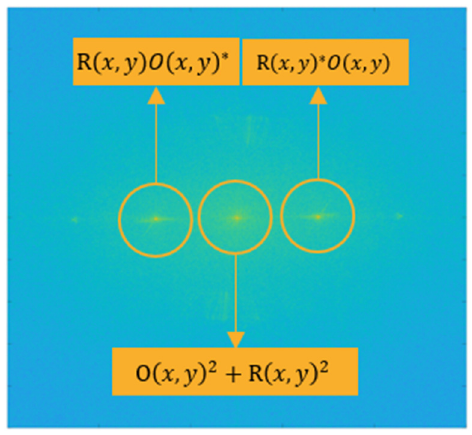
Figure 5. Fourier spectrum distribution of the captured hologram.